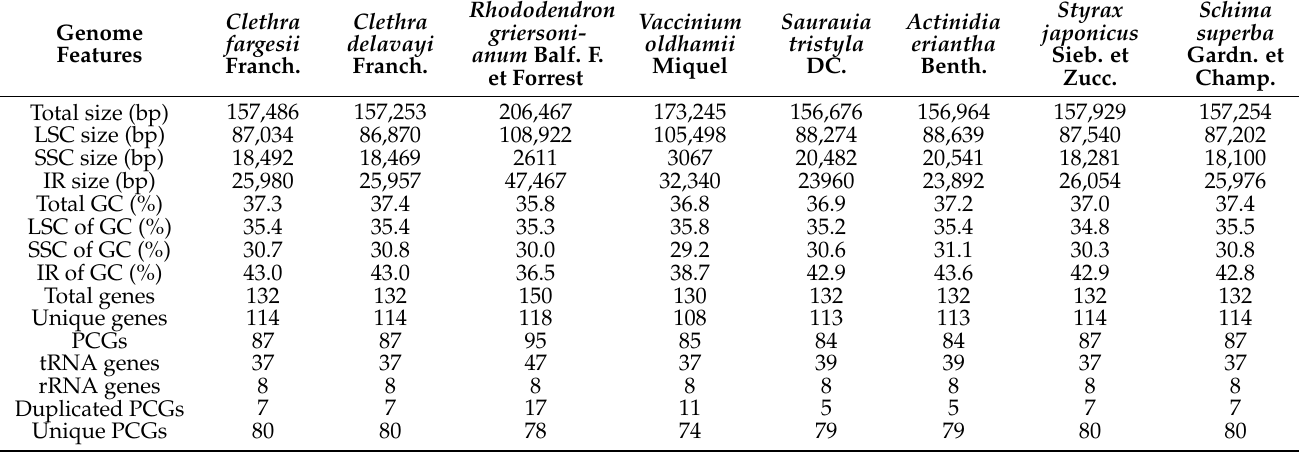
Table 1. Features of the complete chloroplast genomes of C. fargesii and seven related species in Ericales order. Genome